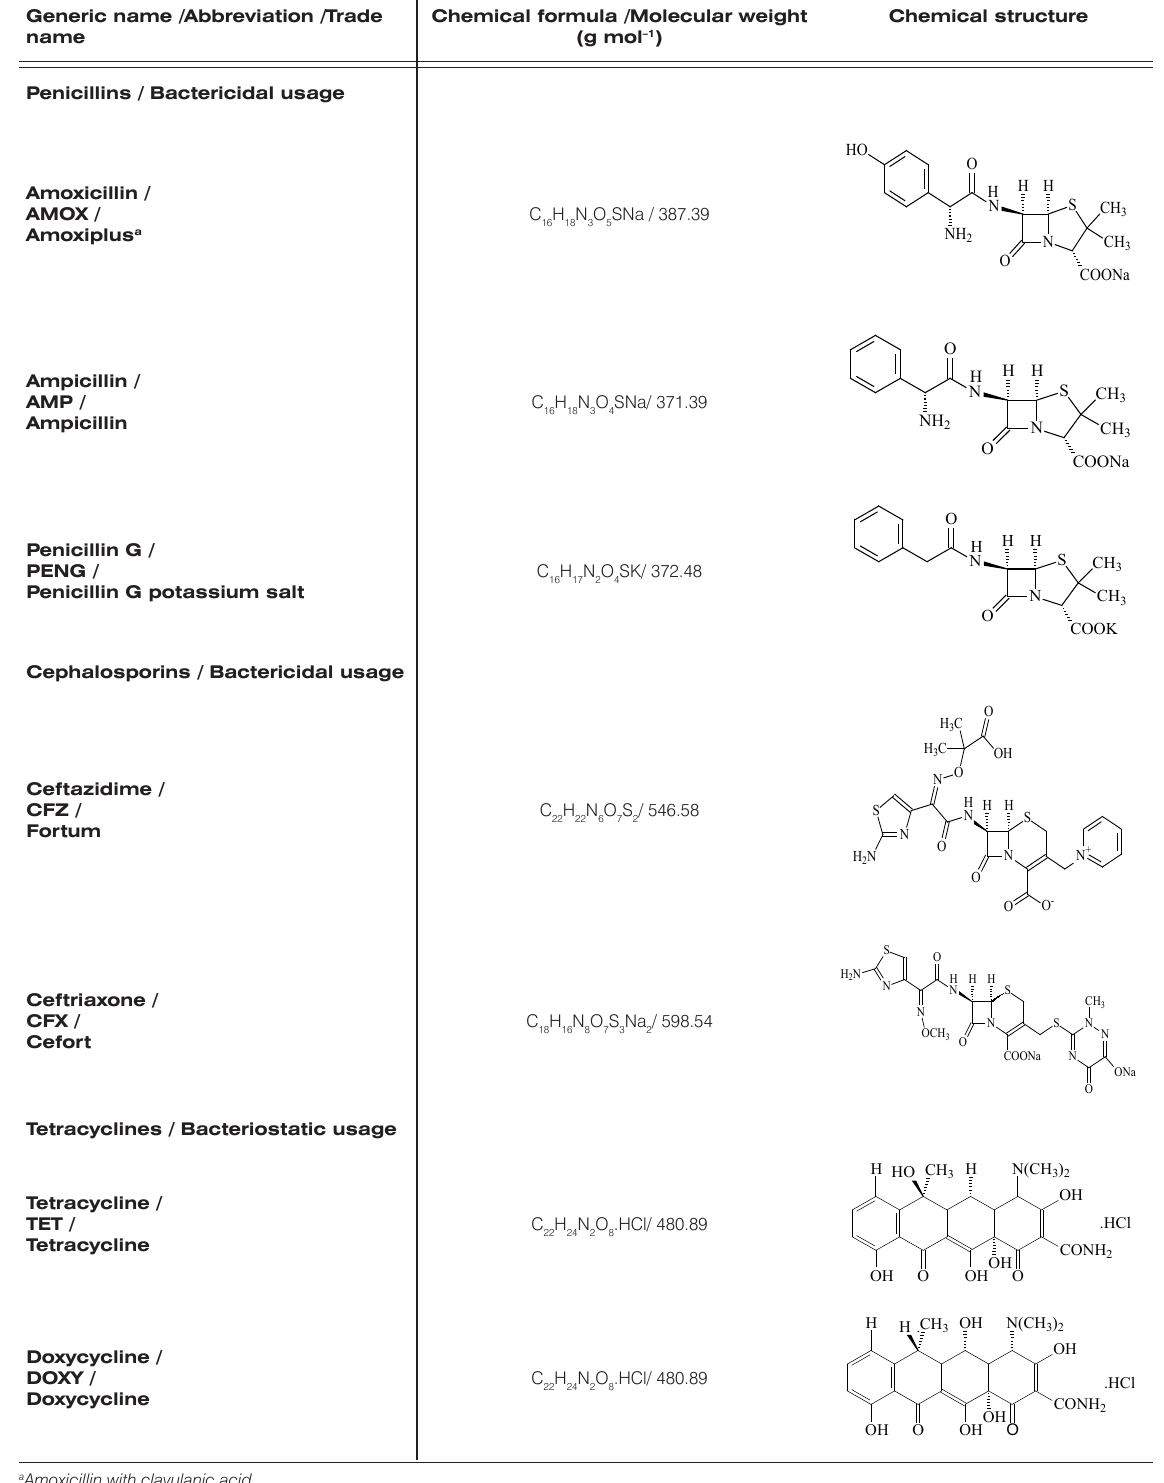
Table 1. Data of the studied